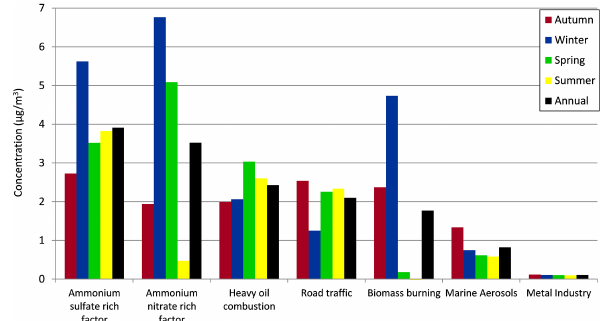
Figure 8. Variations of the seasonal averaged contributions (µgm − 3 ) of the seven sources of PM 2 . 5 . Note that calendar seasons were used (see Table 3 for more